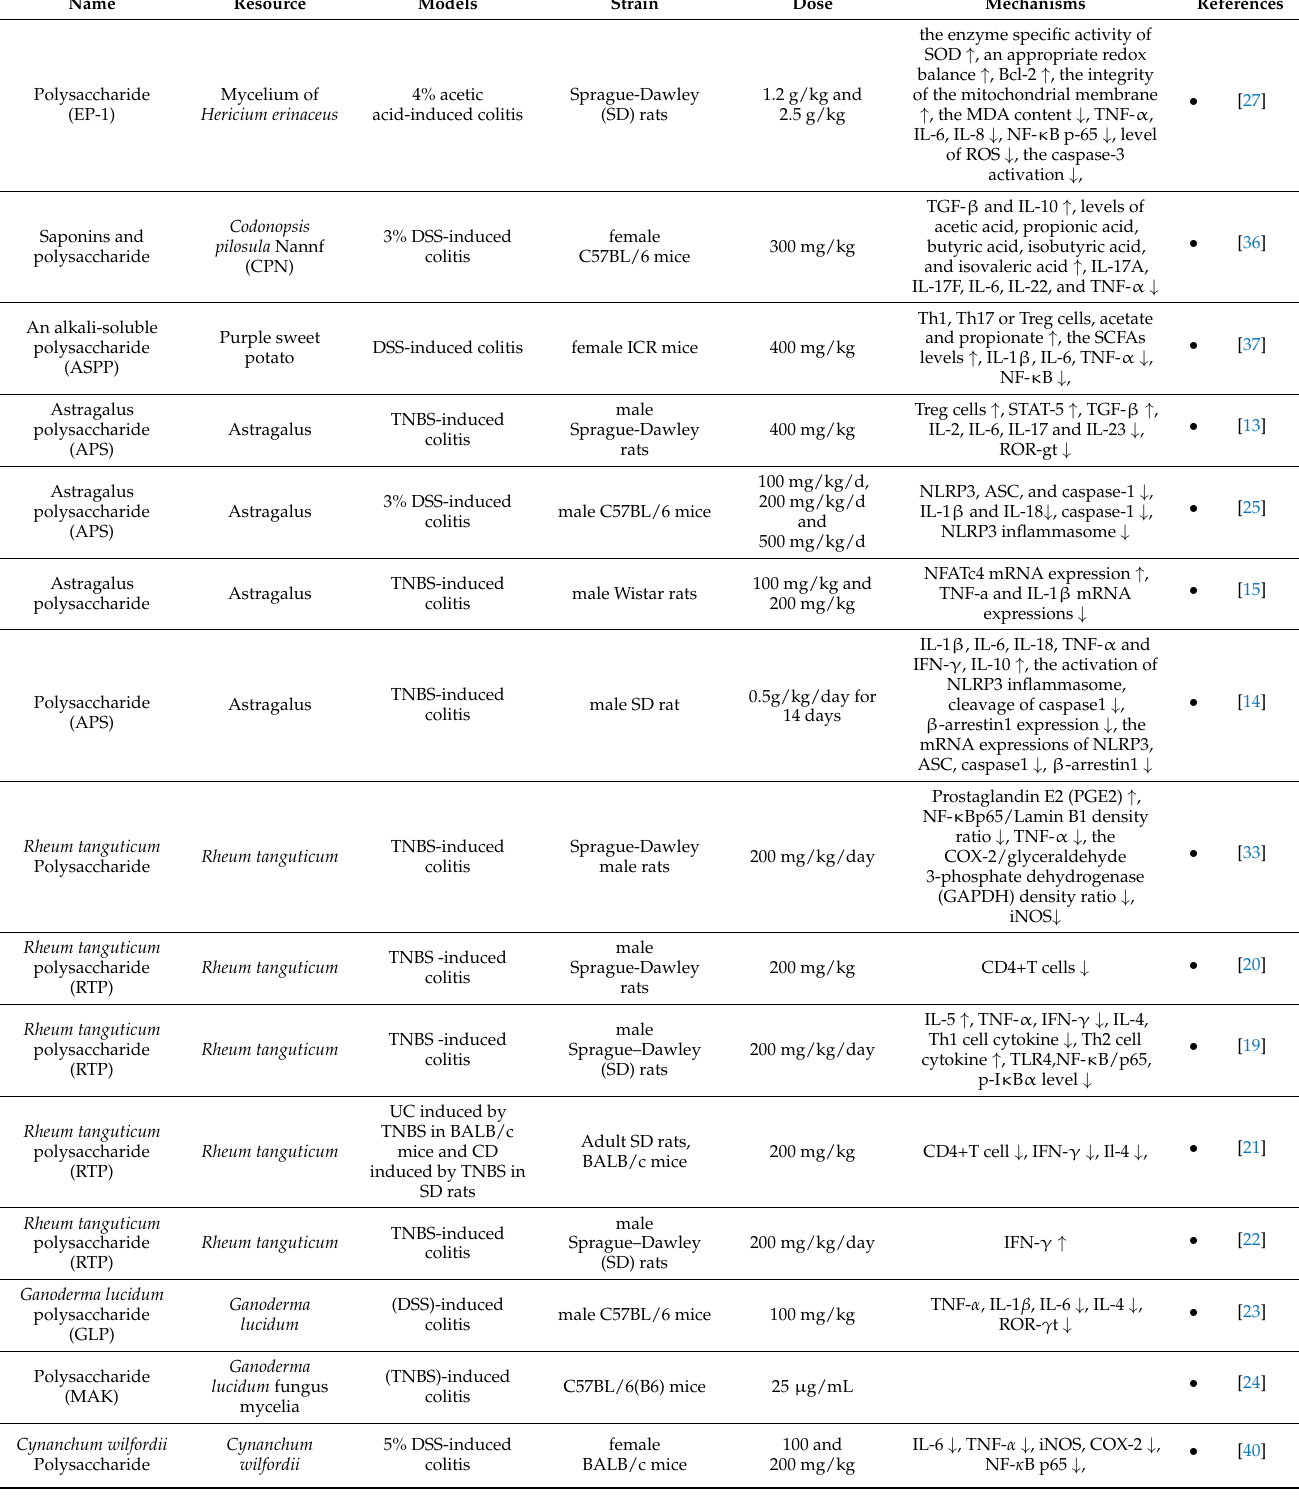
Table 1. The mechanisms of different polysaccharides on experimental